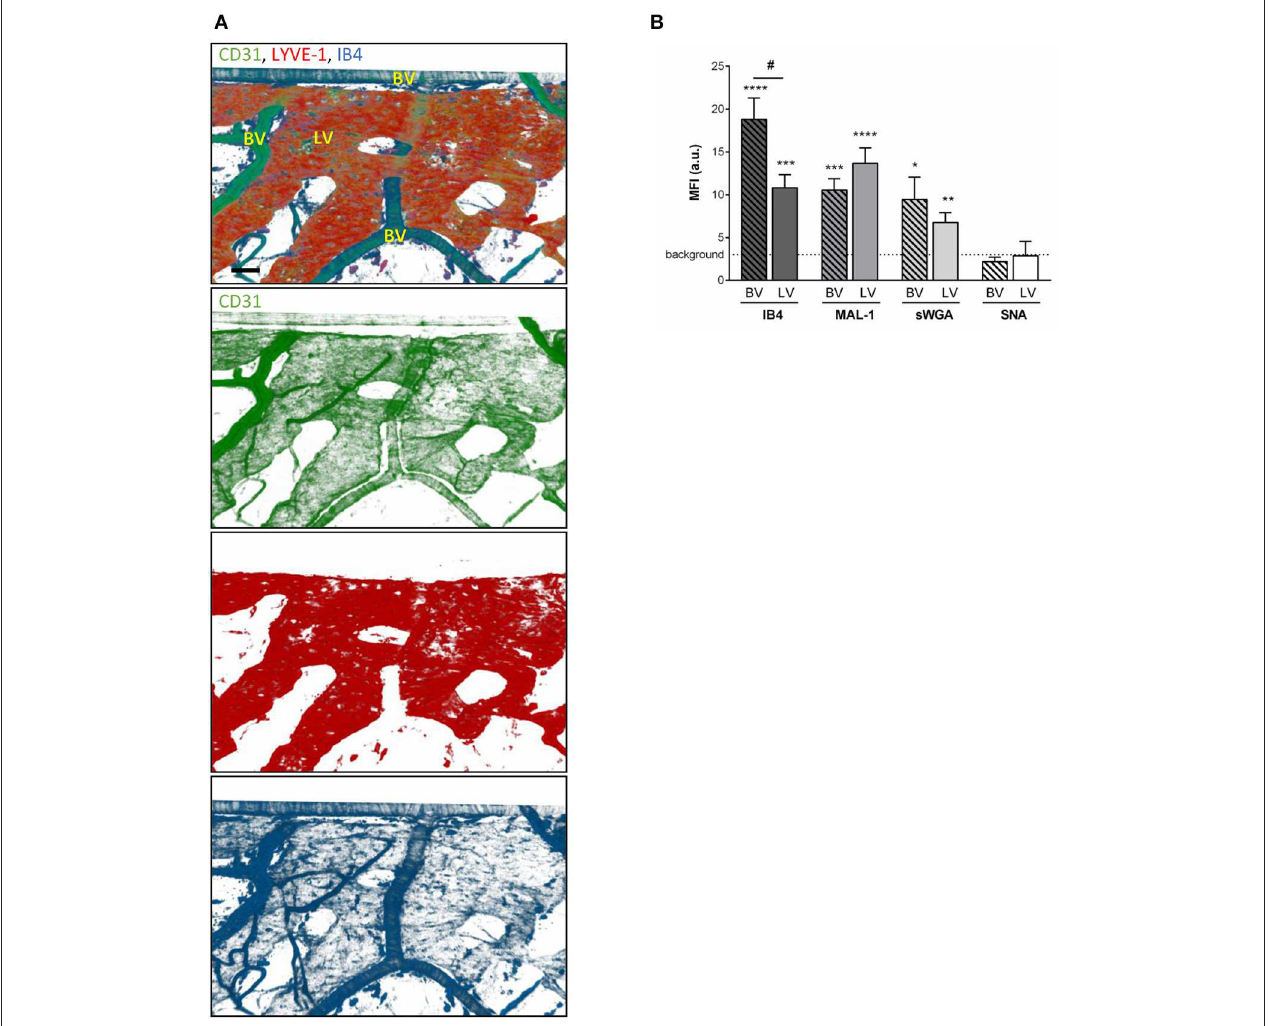
FIGURE 3 | Comparison of the glycocalyx composition between initial lymphatics and blood vessels. Cremaster muscles from WT mice were whole-mount immunostained for the visualization of endothelial cells (anti-CD31 Ab, green), lymphatic vessels (anti-LYVE-1 Ab, red) and glycosylic chains from glycocalyx (lectin, blue) via i.s. injection of the antibodies/lectin for 2h prior to being observed by confocal microscopy. (A) Representative 3D-reconstructed confocal images of a region of the tissue showing that IB4 binds to the blood vessels (BV) and lymphatics (LVs). (Bar = 100 um). (B) Quantification of the mean fluorescence intensity (MFI) for IB4, MAL-1, sWGA, and SNA binding to the surface of initial lymphatics and blood vessels as detailed in the Material and Methods. Data are expressed as mean ± SEM from at least 8–10 vessels/animal, with at least 5 animals per group. Significant differences between BV/LV MFI and background MFI are indicated by asterisks: * P < 0.05, ** P < 0.01, *** P < 0.001, **** P < 0.001; and between BV and LV groups by hash symbol: # P <